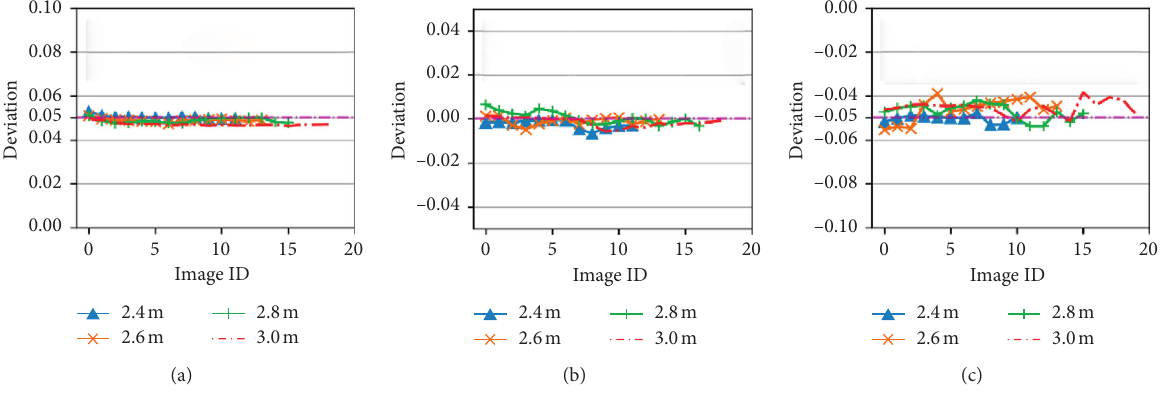
Figure 10: Detection results of the idlers, lines, and arcs. (a) Outer idler, DD: +5%. (b) Outer idler, DD: 0%. (c) Outer idler, DD: − 5%. (d) Inner idler, DD: +5%. (e) Inner idler, DD: 0%. (f) Inner idler, DD: − 5%. 0.10